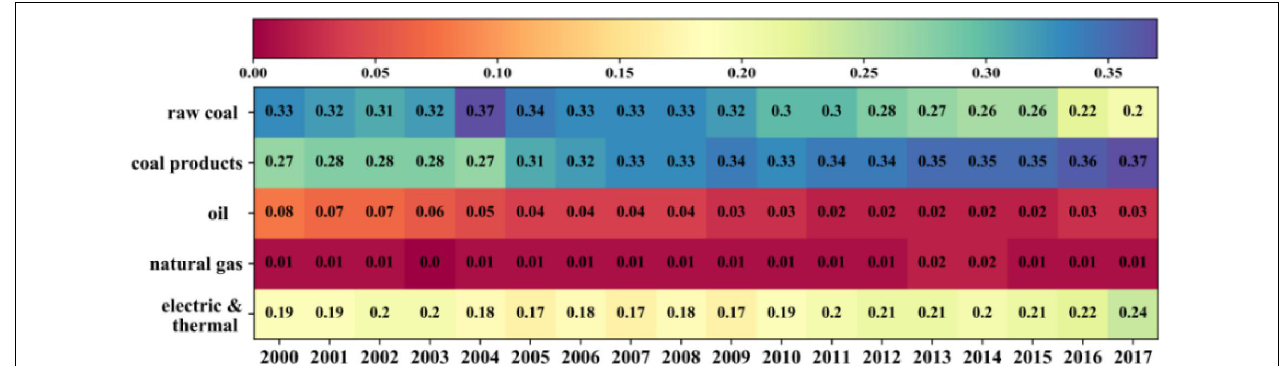
FIGURE 1 | Energy consumption of manufacturing industry in